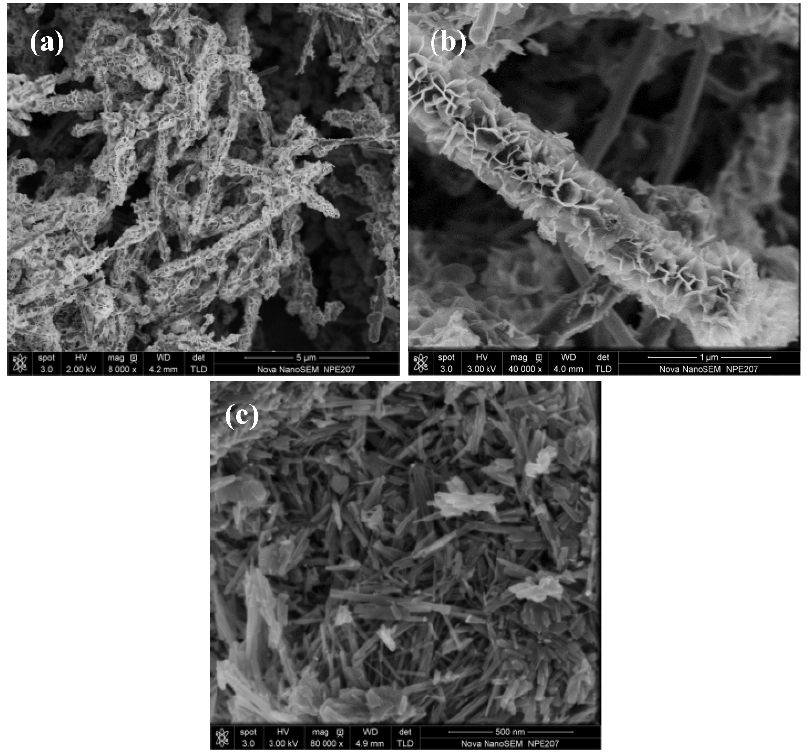
Figure 1. ( a , b ) SEM of the MnO 2 @VGCFs composites, ( c ) SEM micrograph of the MnO 2